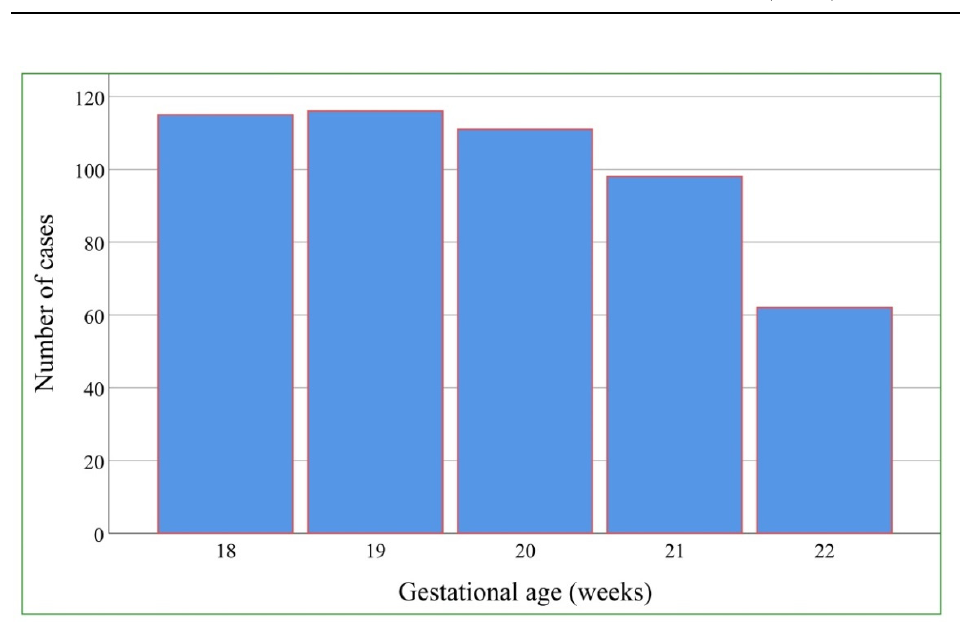
Figure 2. Distribution of gestational age at the time of ultrasound diagnosis. The performance of CV Z-scores is slightly better than that of CTR Z-scores, but very superior to that of MCA-PSV MoM values; the areas under curve (AUC) are